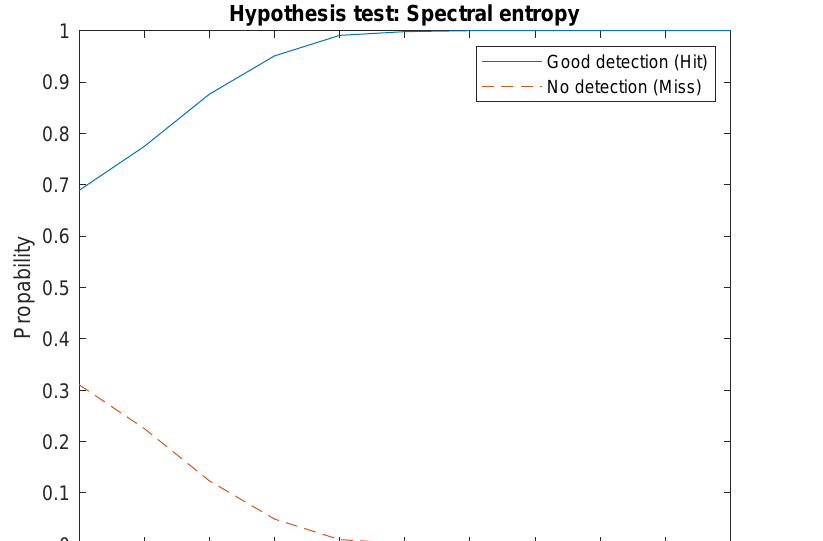
Figure 4. Histogram for PSE.